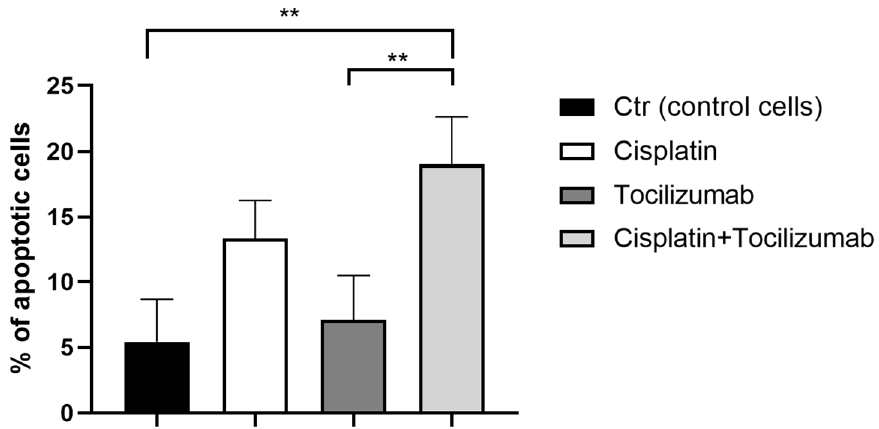
Figure 6. Tocilizumab combined with cisplatin induces a significant apoptotic effect. Apoptotic cell death in KATO III GC cell lines exposed to 10 µ M of cisplatin or 50 mg/mL of tocilizumab or the combination of both agents for 48 h by apoptotic assay. The data are expressed as the means ± SD. The significance was determined by one-way ANOVA followed by Dunnett’s multiple comparison tests: ** ( p < 0.01).